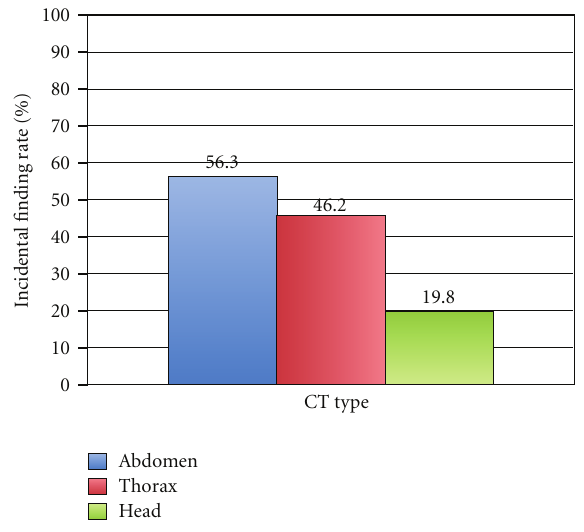
Figure 1: Incidental finding rates by CT